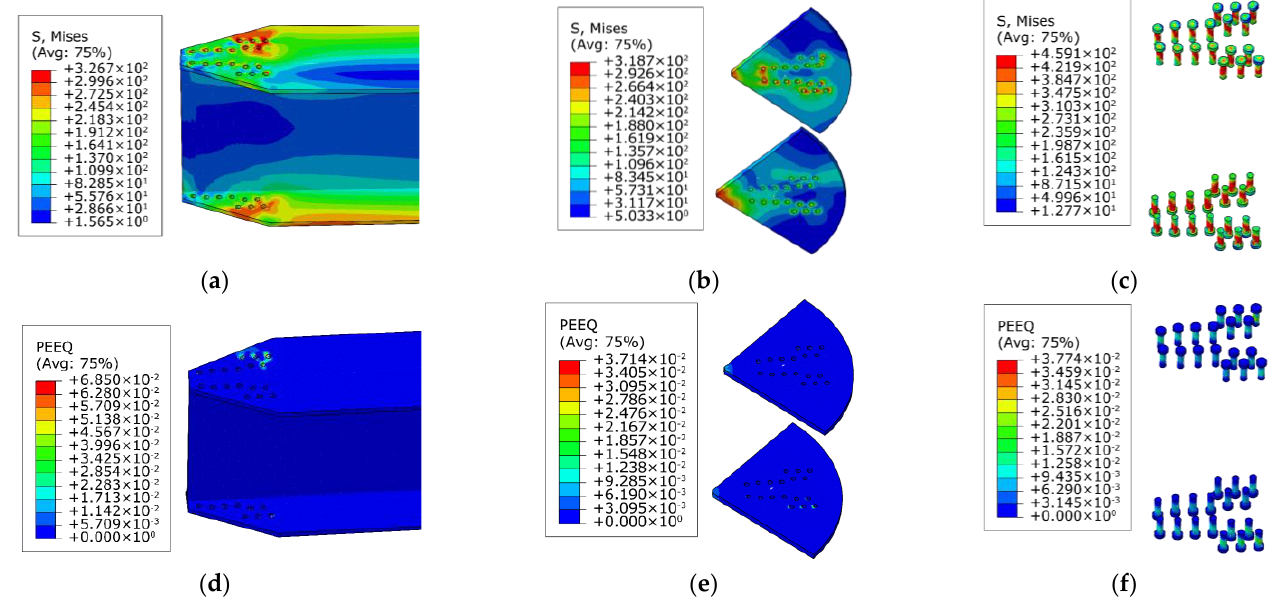
Figure 15. Stress clouds and plastic strain maps of J(350-9-275-12-0.3). ( a ) Stress cloud of member; ( b ) stress cloud of joint plates; ( c ) stress cloud of bolts; ( d ) plastic strain of member; ( e ) plastic strain of joint plates; ( f ) plastic strain of bolts.